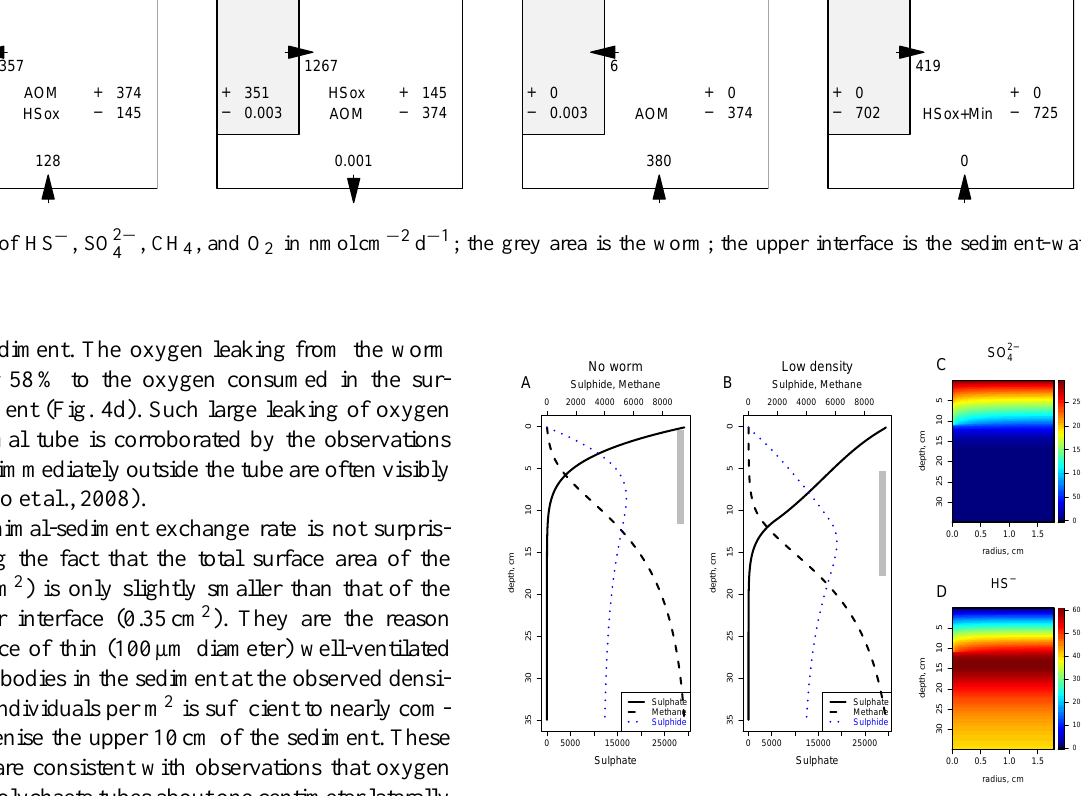
Fig. 5. (A) Radially-averaged concentration profiles in the ab- sence of bio-irrigation; the grey box is the AOM zone. (B) Radially-averaged concentration profiles for a low worm density of 1000indm − 2 . (C) 2-D image plots of sulfate for the low worm den- sity case. (D) 2-D image plots of sulfide for the low worm density case. Units are mmolm − 3